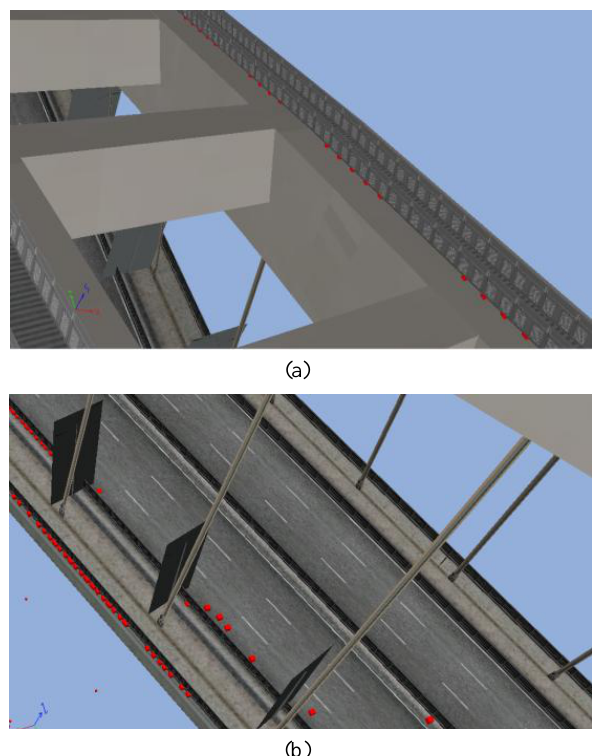
Figure 7. Triple bounce(cubes in red color) on the (a) arc and (b) road of the Lupu Bridge.